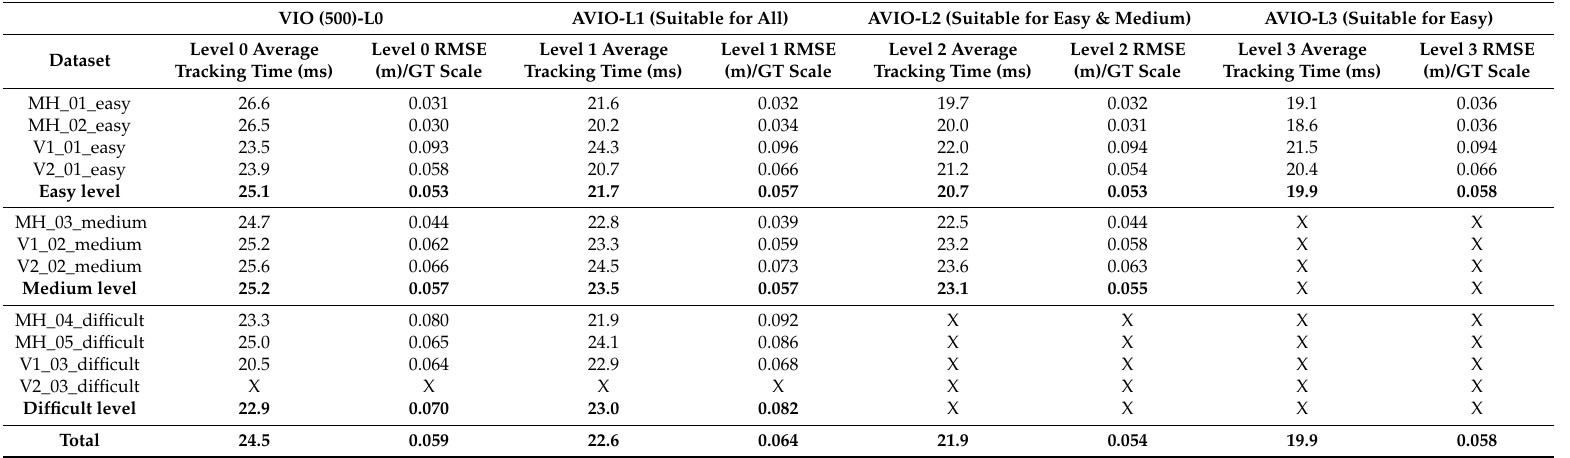
Table 7. Evaluation of AVIO-based SLAM.